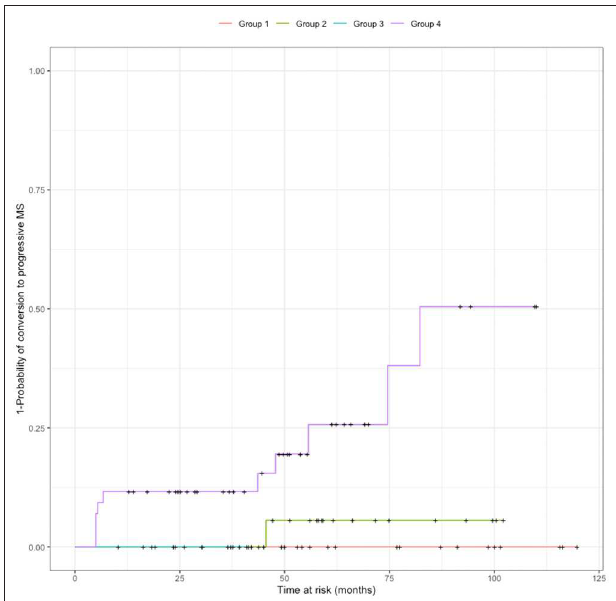
FIGURE 3 | Probability of conversion to SPMS according to biomarker profile. Patients were cathegorized according to NFL and CHI3L1 median values (calculated in the RRMS cohort without disease activity) into four groups: Group 1: both NFL and CHI3L1 below median value; Group 2: high NFL; Group 3: High CHI3L1; Group 4: NFL and CHI3L1 above median values. Patients included in group 4 had more probability to be diagnosed of SPMS during follow-up than patients pertaining to the other groups (log rank p = 0.02). SPMS: secondary progressive multiple